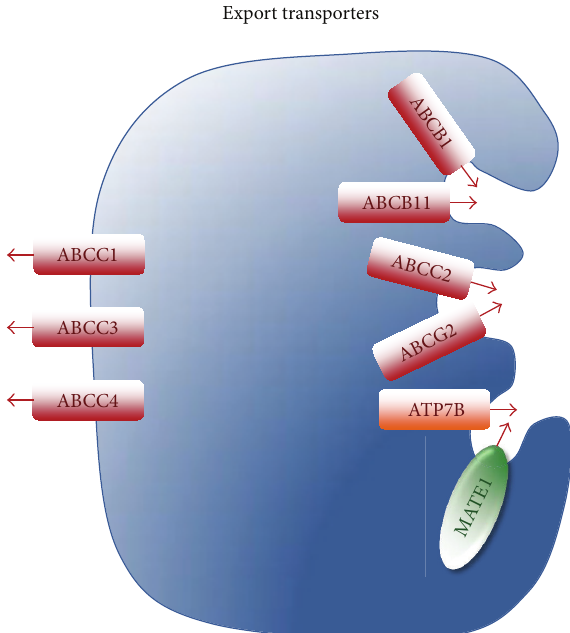
F 2: Export pumps involved in drug export across the basolateral and canalicular membrane of